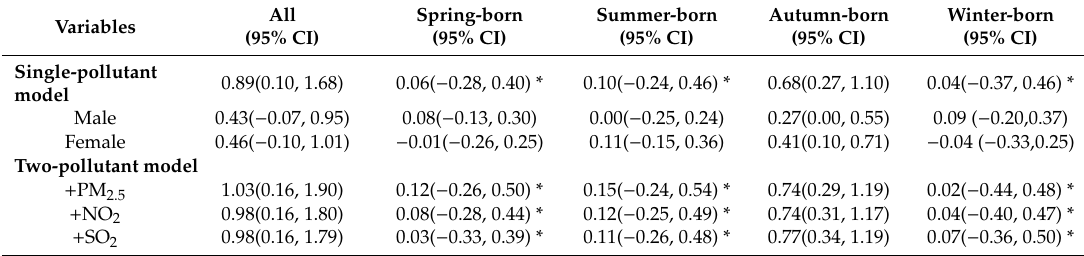
Table 3. Changes in years of life lost (YLL) from hypertension per 10 µ g / m 3 increase in ozone in the elderly individuals born in di ff erent seasons using single and two-pollutant models in Ningbo, China, from 2013 to 2016. All (95%